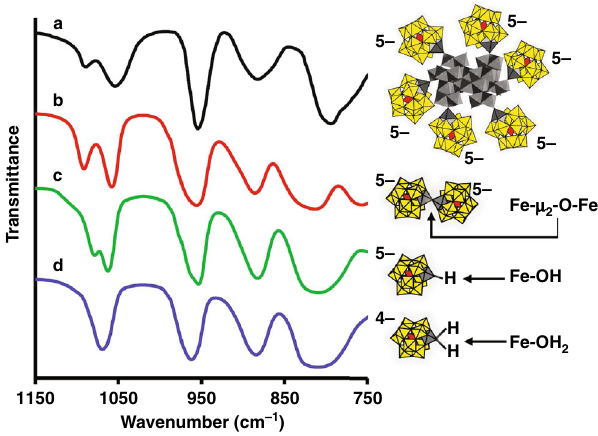
Fig. 3 FTIR spectral evidence for Fe – μ 2 -O – Fe linkages to α -[PW 11 O 39 Fe] – O – ligands in 1 . a and b FTIR spectra, respectively, of 1 (baseline corrected — see Supplementary Figure 20a) and the μ 2 -oxo-bridged dimer, [( α - PW 11 O 39 Fe) 2 – μ 2 -O] 10 – ( 2 ). (The lowest-energy band in a is distorted by overlap with bands from α -Fe 2 O 3 ). The IR-active PO 4 modes in a and